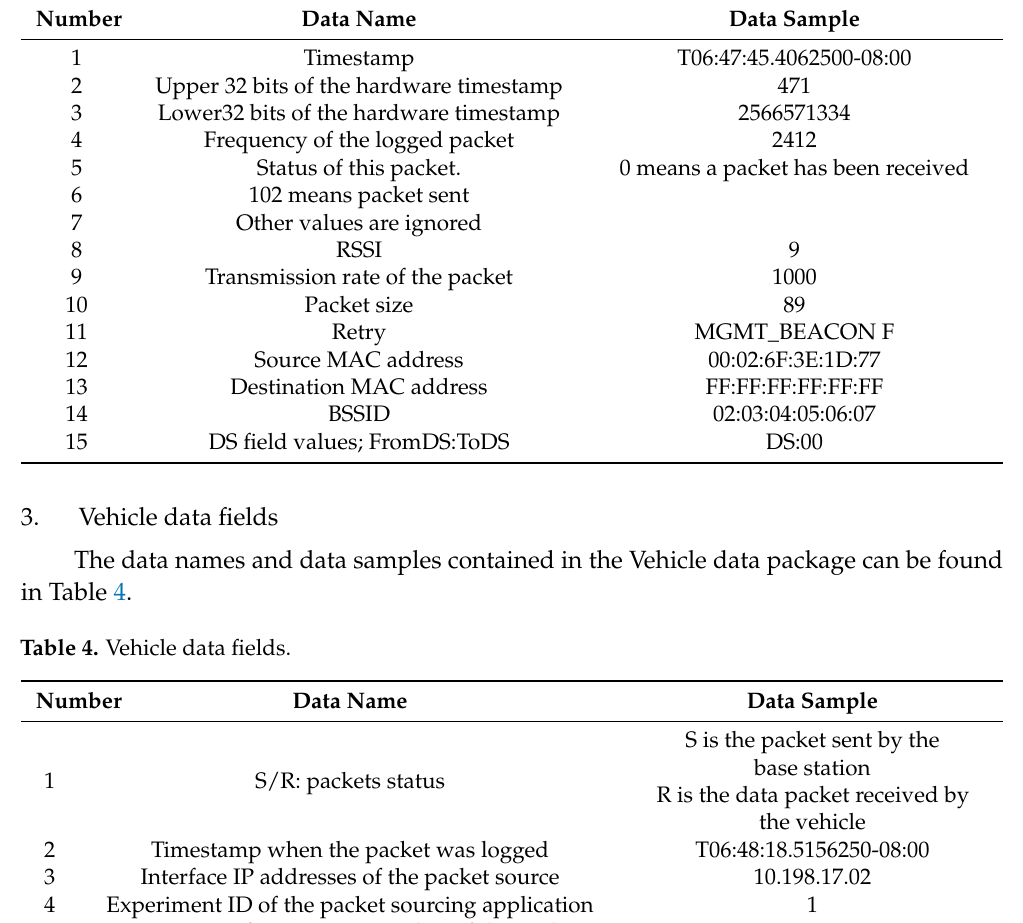
Table 3. Wi-Fi data fields.